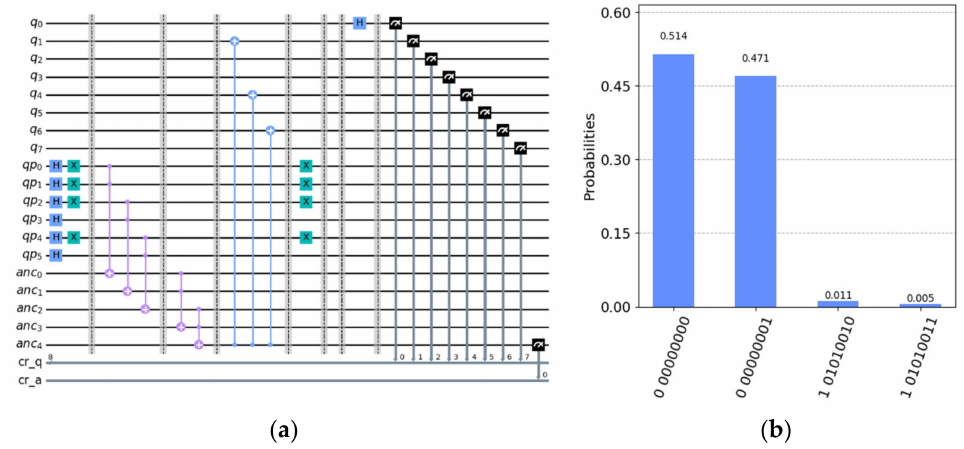
Figure 9. ( a ) The NEQR representation for the sixth pixel (gray level 82, LSB set to 0) and ( b ) the measurement results.